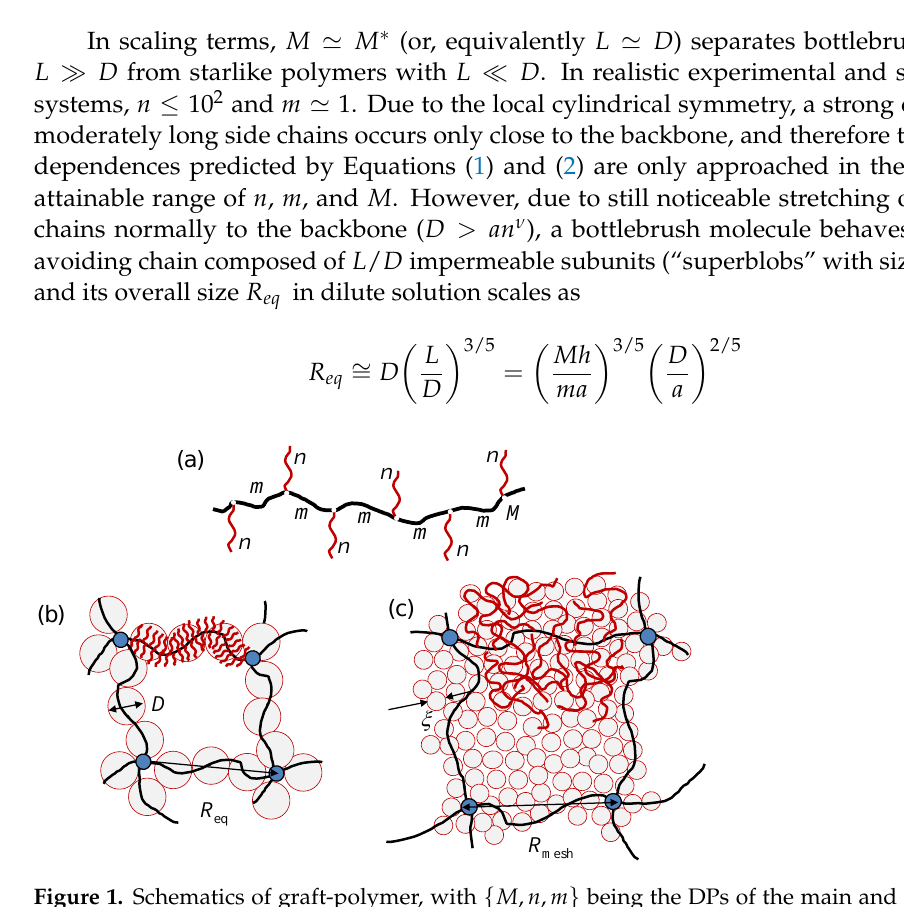
M , n , m Figure 1. Schematics of graft-polymer, with being the DPs of the main and side chains { } and of the spacers, respectively. ( a ) Hairy gel with bottlebrush strands in hollow mesh ( b ) and filled mesh ( c ) regimes. Backbones of strands are colored in black, side chains are in red, and cross-links are marked as blue circles. R eq is the equilibrium end-to-end distance of the main chains of the gel strands (the mesh size). Superblobs with size D (hollow-mesh regime) and concentration blobs with size ξ < D in semi-dilute solution of side chains (filled-mesh regime) are shaded light gray. Distribution of polymer’s density within a swollen hairy gel could be